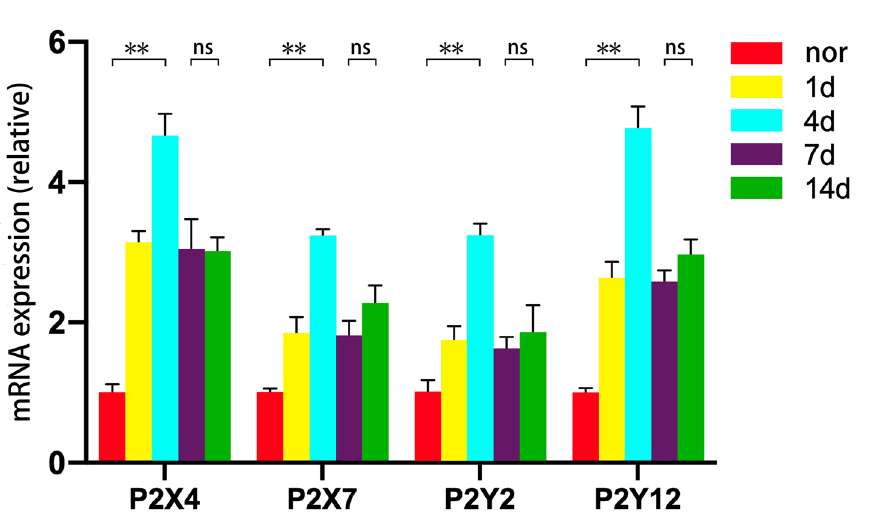
Figure 1. Cryosections of treated mouse eyes stained against Iba1 (green) and P2 receptors (red) on different time points after laser treatment as indicated. The arrow showed the cells which were positive for Iba1 and P2 at the same time. Scale bar: 200 µm.